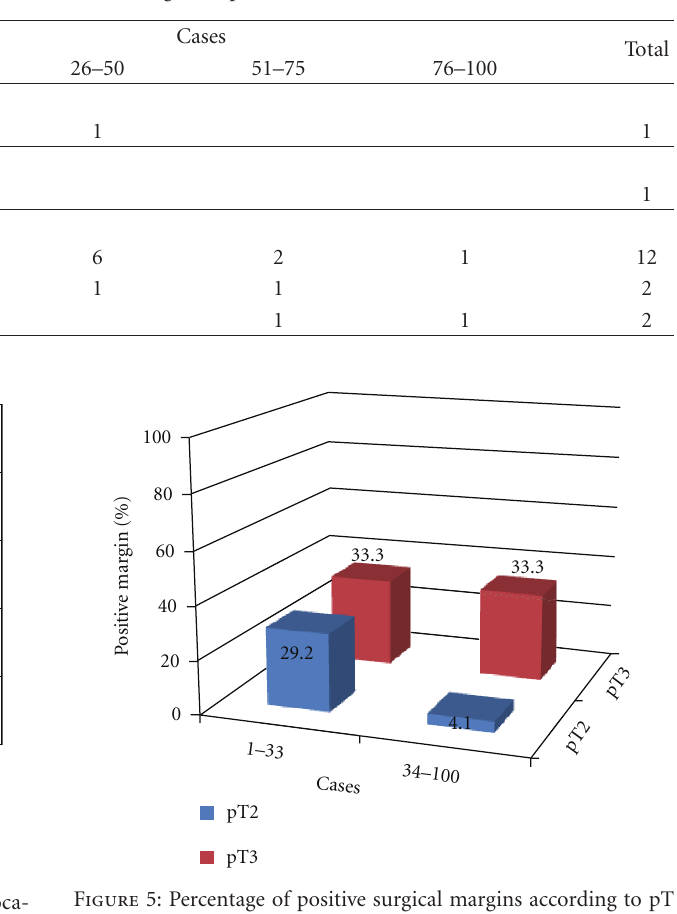
Table 3: Complications related to the surgical experience.